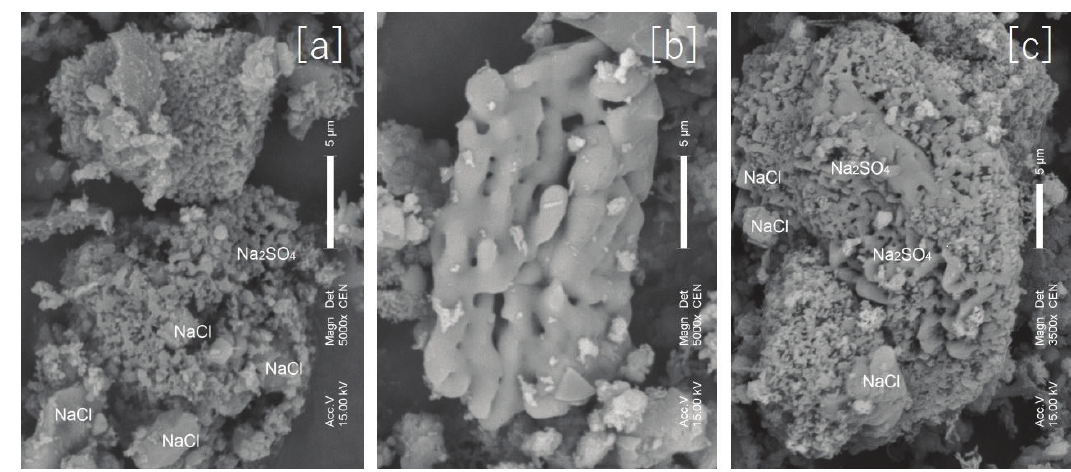
Fig. 14 – Surface of the sodium compound, magnification: 5000x: a) Na Fig. 14 Surface of the sodium compound, magnification: 5000x: a) Na cles of Na CO particles of Na SO and NaCl, b) sodium sulphate grain, c) expanded particles of Na 2 3 2 4